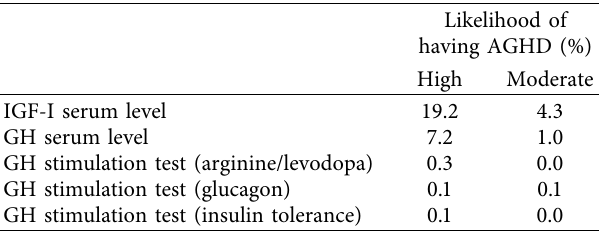
Table 3: Diagnostic tests for GHD in the study cohort by the likelihood of having